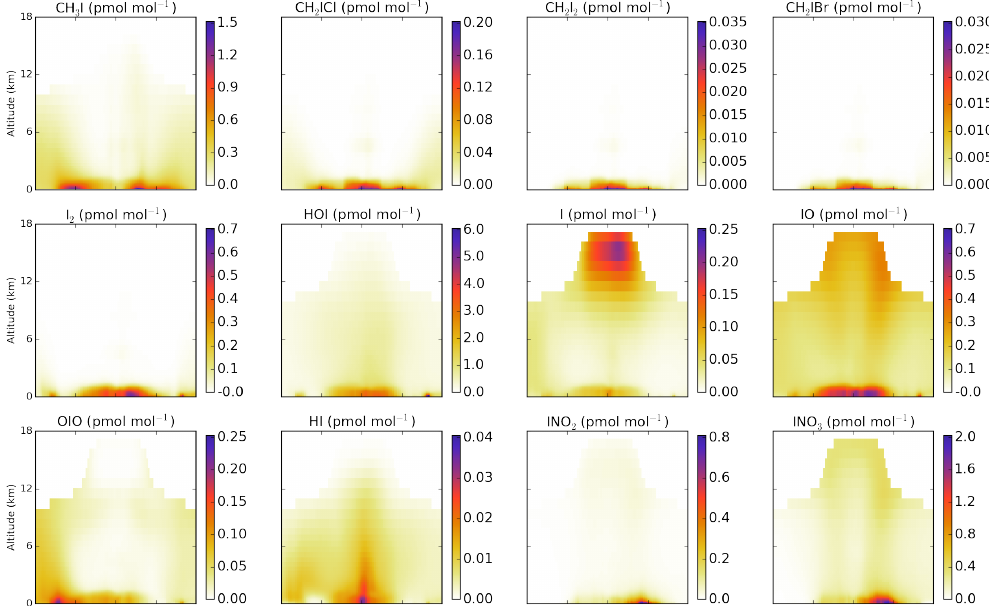
Figure 2. Annual mean zonal tropospheric mixing ratios for precursor and reactive iodine compounds (pmolmol − 1 ) in the simulation with both iodine and bromine chemistry (“Br + I”). No calculations of concentrations are made within the stratosphere and so that region is left blank. Table 6. Heterogeneous reactions of iodine species. Where measured values have not been reported estimated values are used and no reference is given, further detail on uptake choices is in Sect. A1.2. Asterisked ( ∗ ) reactions proceed only on sea-salt aerosols. ID Reaction Reactive uptake coefficient ( γ ) Reference K1 HI → iodine aerosol 0 . 10 ∗ Crowley et al. (2010) K2 INO 3 → 0 . 5I 2 0 . 01 ∗ see caption text K3 HOI → 0 . 5I 2 0 . 01 ∗ Sander et al. (2011) K4 INO 2 → 0 . 5I 2 0 . 02 ∗ see caption text K5 I 2 O 2 → iodine aerosol 0.02 see caption text K6 I 2 O 4 → iodine aerosol 0.02 see caption text K7 I 2 O 3 → iodine aerosol 0.02 see caption